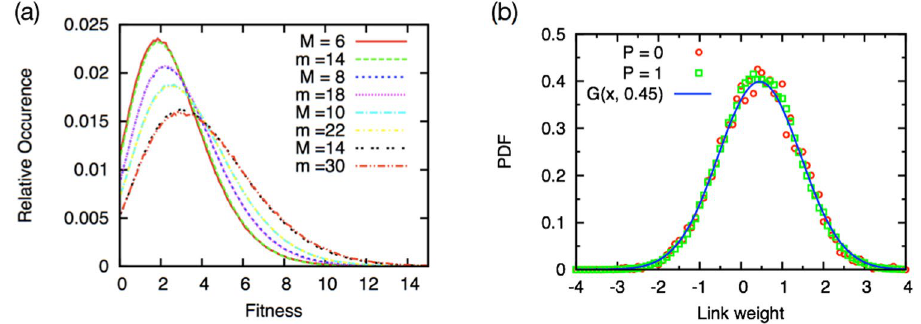
Figure 7. Scaling relation in the fitness distribution function. ( a ) Fitness distributions of the unidirectional model ( m = 14, 18, 22, and 30) and of the bidirectional model ( M = 6, 8, 10, and 14). ( b ) Link weight distributions of the unidirectional model with m P = 0 = 18 and of the bidirectional model with M P = 1 = 8. Solid blue line is a fitting function, a standard normal distribution function G ( x , μ ) (solid line) with its mean μ = 0.45.